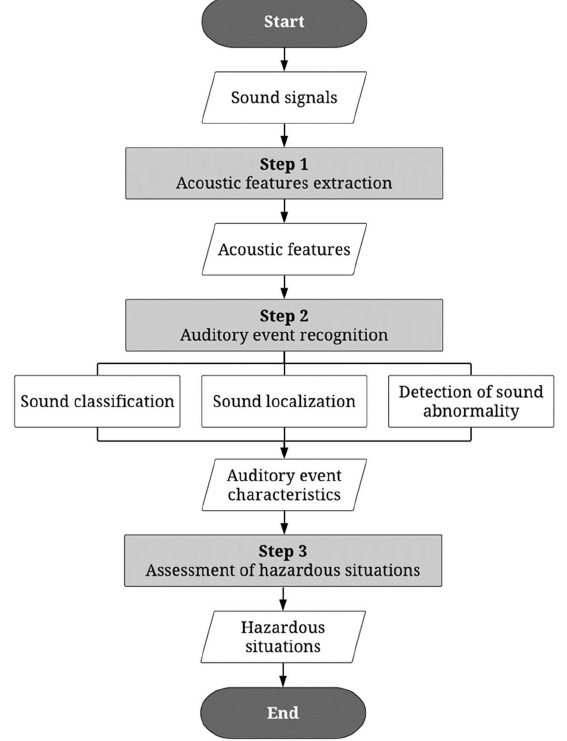
Figure 8. Overall architecture of auditory signal processing to detect hazardous situations.